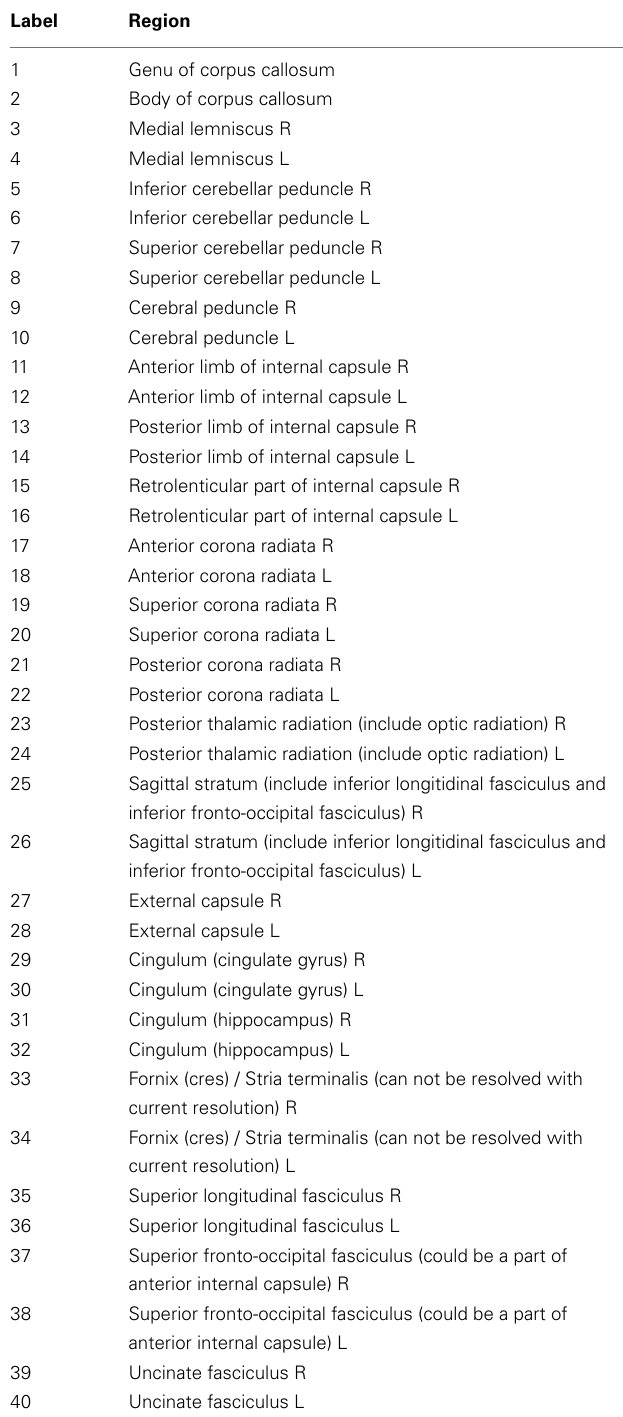
TableA1 | John Hopkins University (JHU) white matter selected labels.